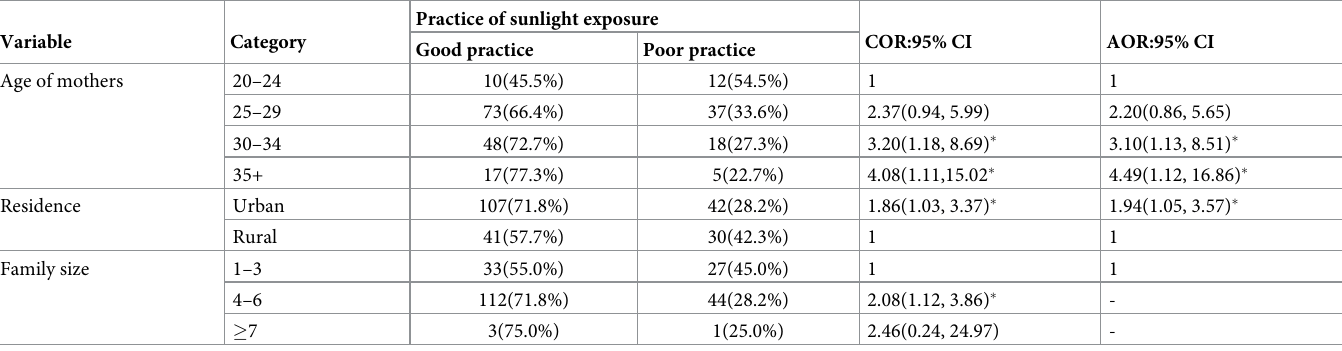
Table 5. Factors associated with sunlight exposure of infants among mothers attending EPI unit at WUSH, 2021.